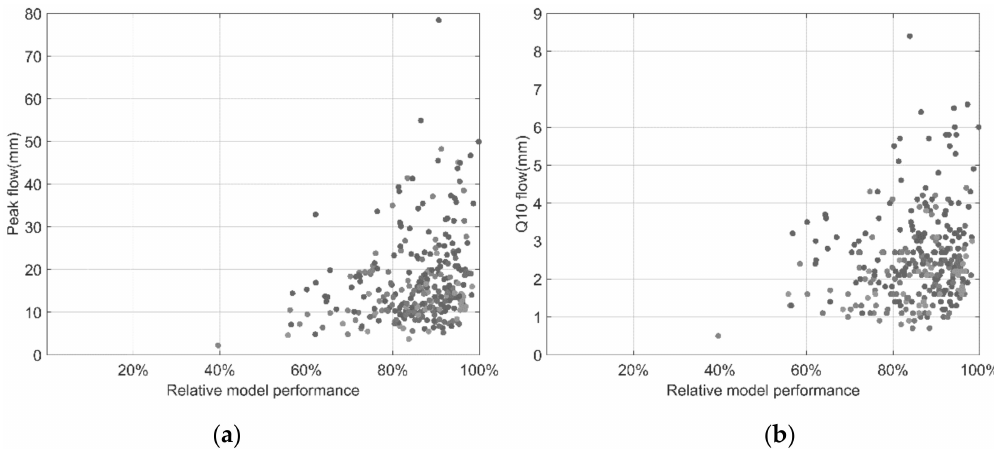
Figure 5. Comparison of relative NSBs for 1970–1979 and the runo ff characteristics during the calibration period. ( a ) Depth of peak flow; ( b ) depth of the 10th-percentile high